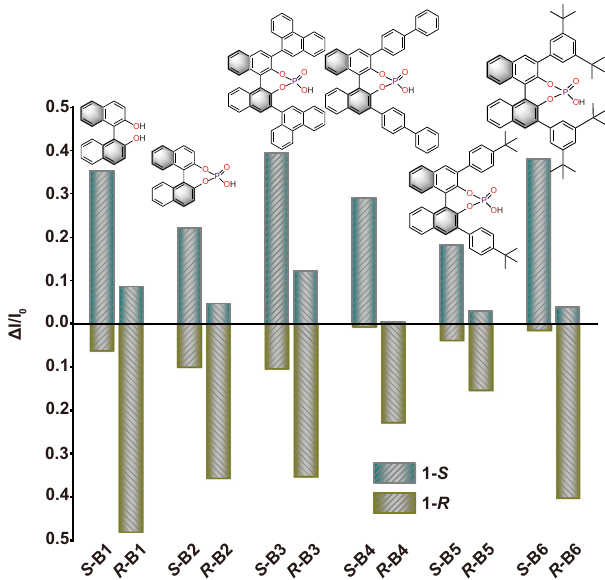
Fig. 6 Ratio of luminescent intensity. Ratio of luminescent intensity after adding 1- S (dark blue column) and 1- R (brown column) into the solution of axial chiral enantiomers ( B1 - B6